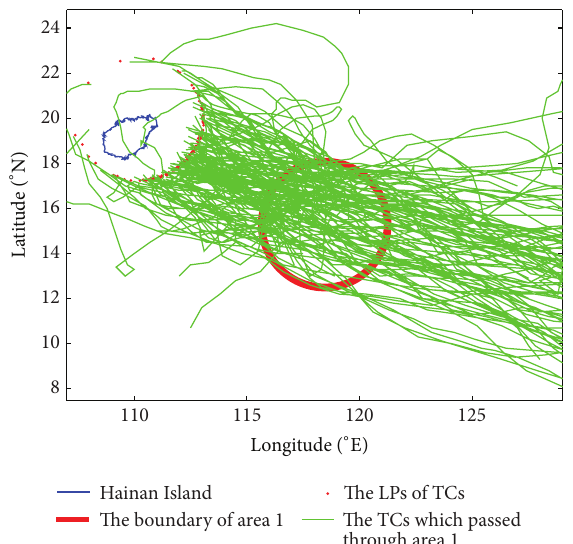
Figure 12: The tracks of historical landing TCs which passed through area 1.